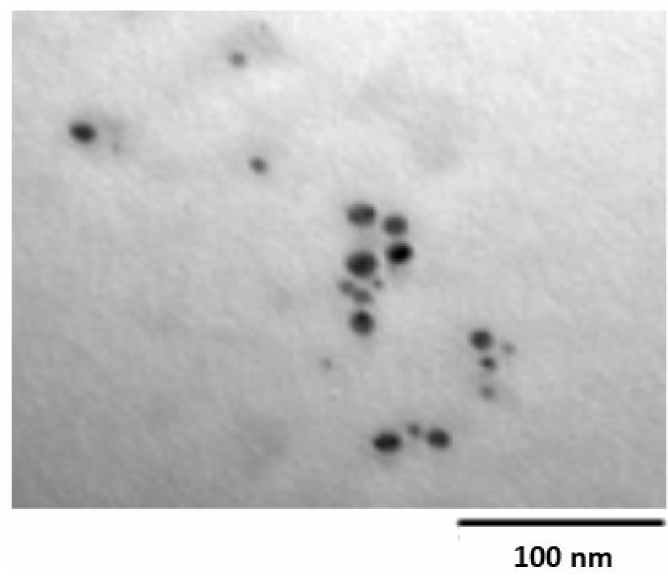
Figure 2. TEM image ZOE-AgNPs.